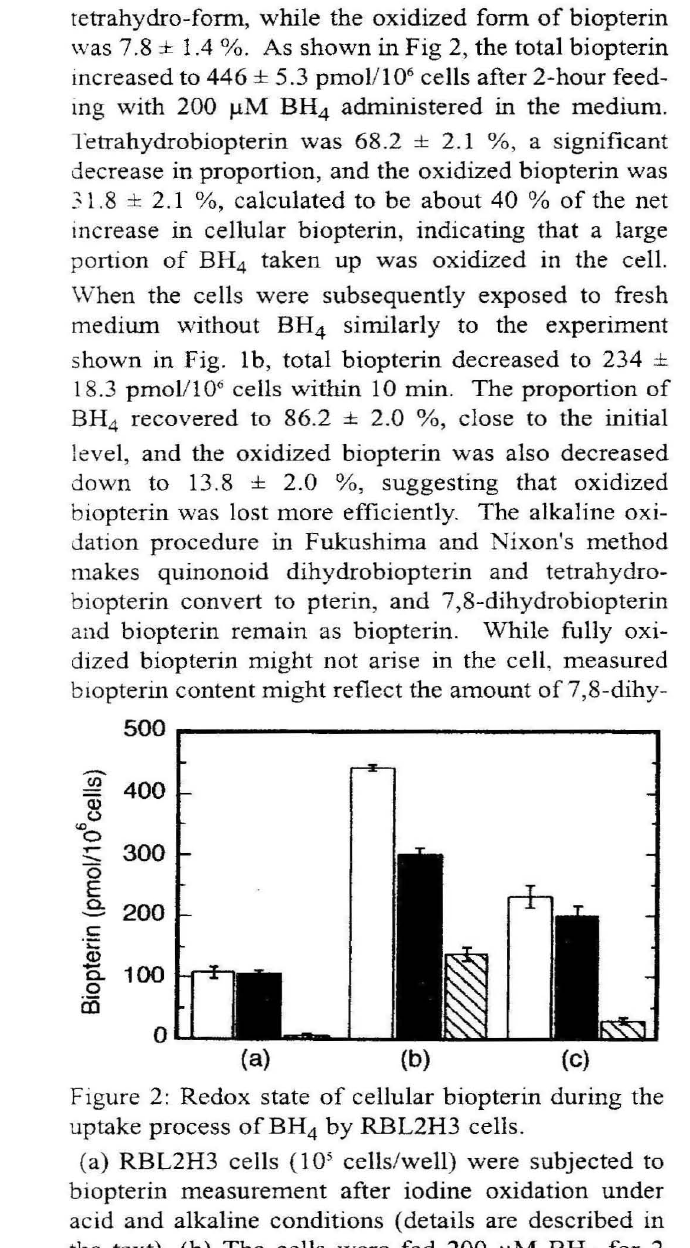
legend of Fig. 2. Open circle: total pterins. Closed cir cle: tetrahydrobiopterin. Closed triangle: dihydro biopterin. Closed tetragon: pterin. Each point indicates the mean ± SO for 4